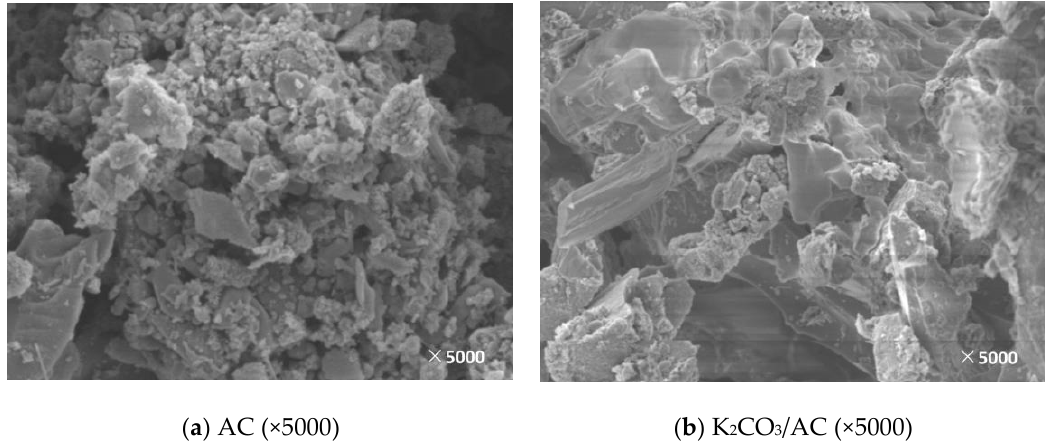
Figure 5. SEM image before and after AC loading. ( a ): The SEM image of AC; ( b ): The SEM image of K 2 CO 3 /AC.